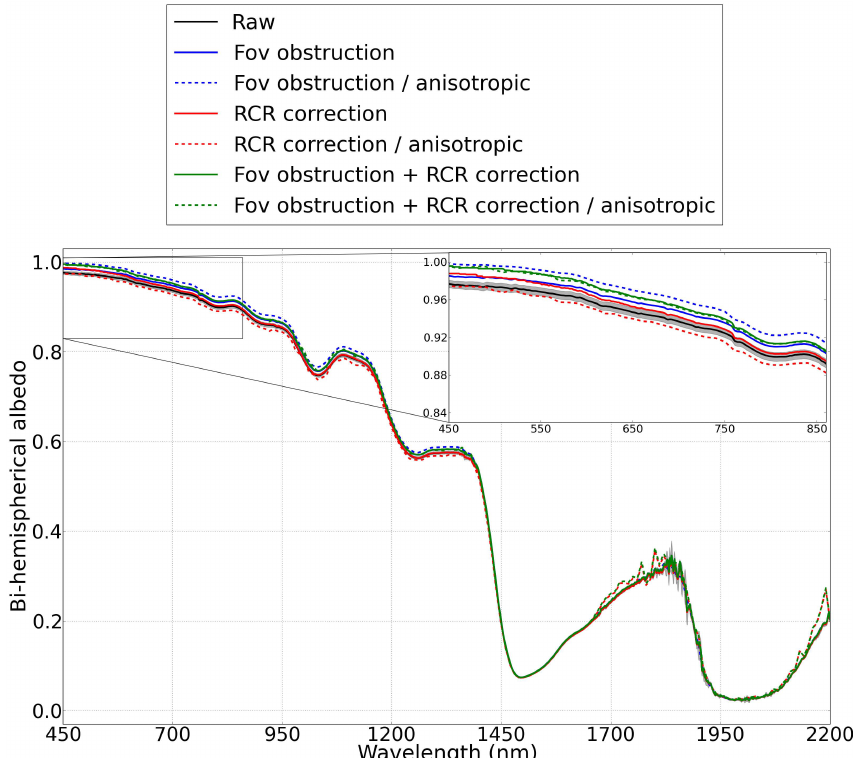
Fig. 4. Impact of corrections on the measured spectral albedo for 20 June 2011. Black line refers to raw ASD data obtained by averaging 4 daily spectra; the resulting standard deviation is represented in grey. The effect of the field of view obstruction by the observer is represented by blue curves, the impact of cosine collector deviation is represented by red curves and the total correction is represented by green curves. In each case, dashed lines show the effect of taking into account the anisotropy of reflected radiation on the correction of spectral albedo (see Eq.